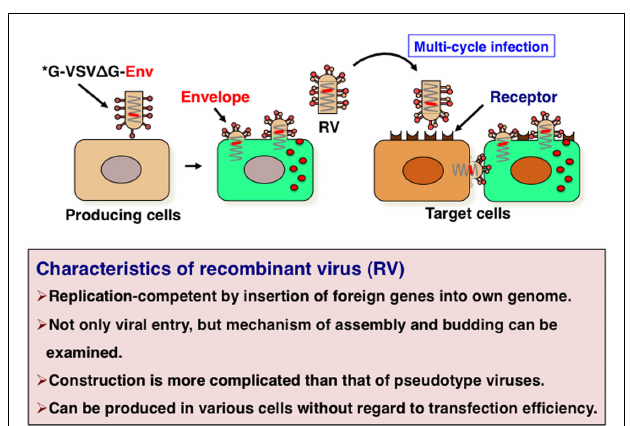
FIGURE 2 | Schematic representation of the production of recombinantVSV. Various mammalian producer cells were inoculated with aVSV G-complemented recombinant virus encoding foreign envelope genes instead ofVSV G.The recombinantVSV was able to undergo a fully productive infection generating infectious progeny viruses that could be passaged into naïve cells.